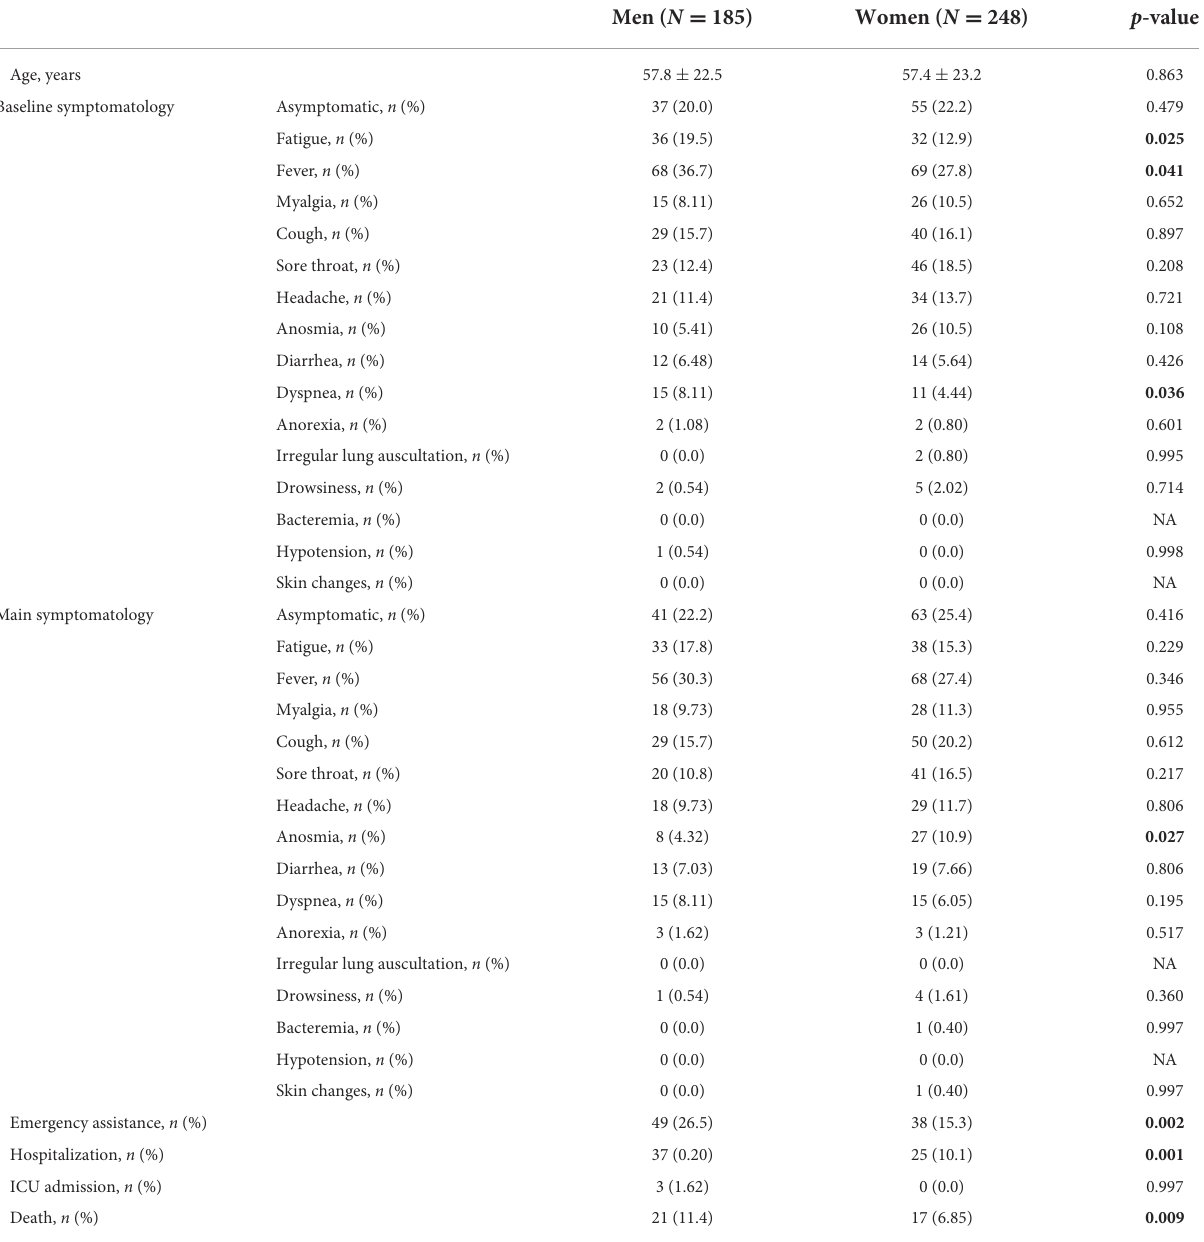
TABLE 2 Clinical characteristics according to